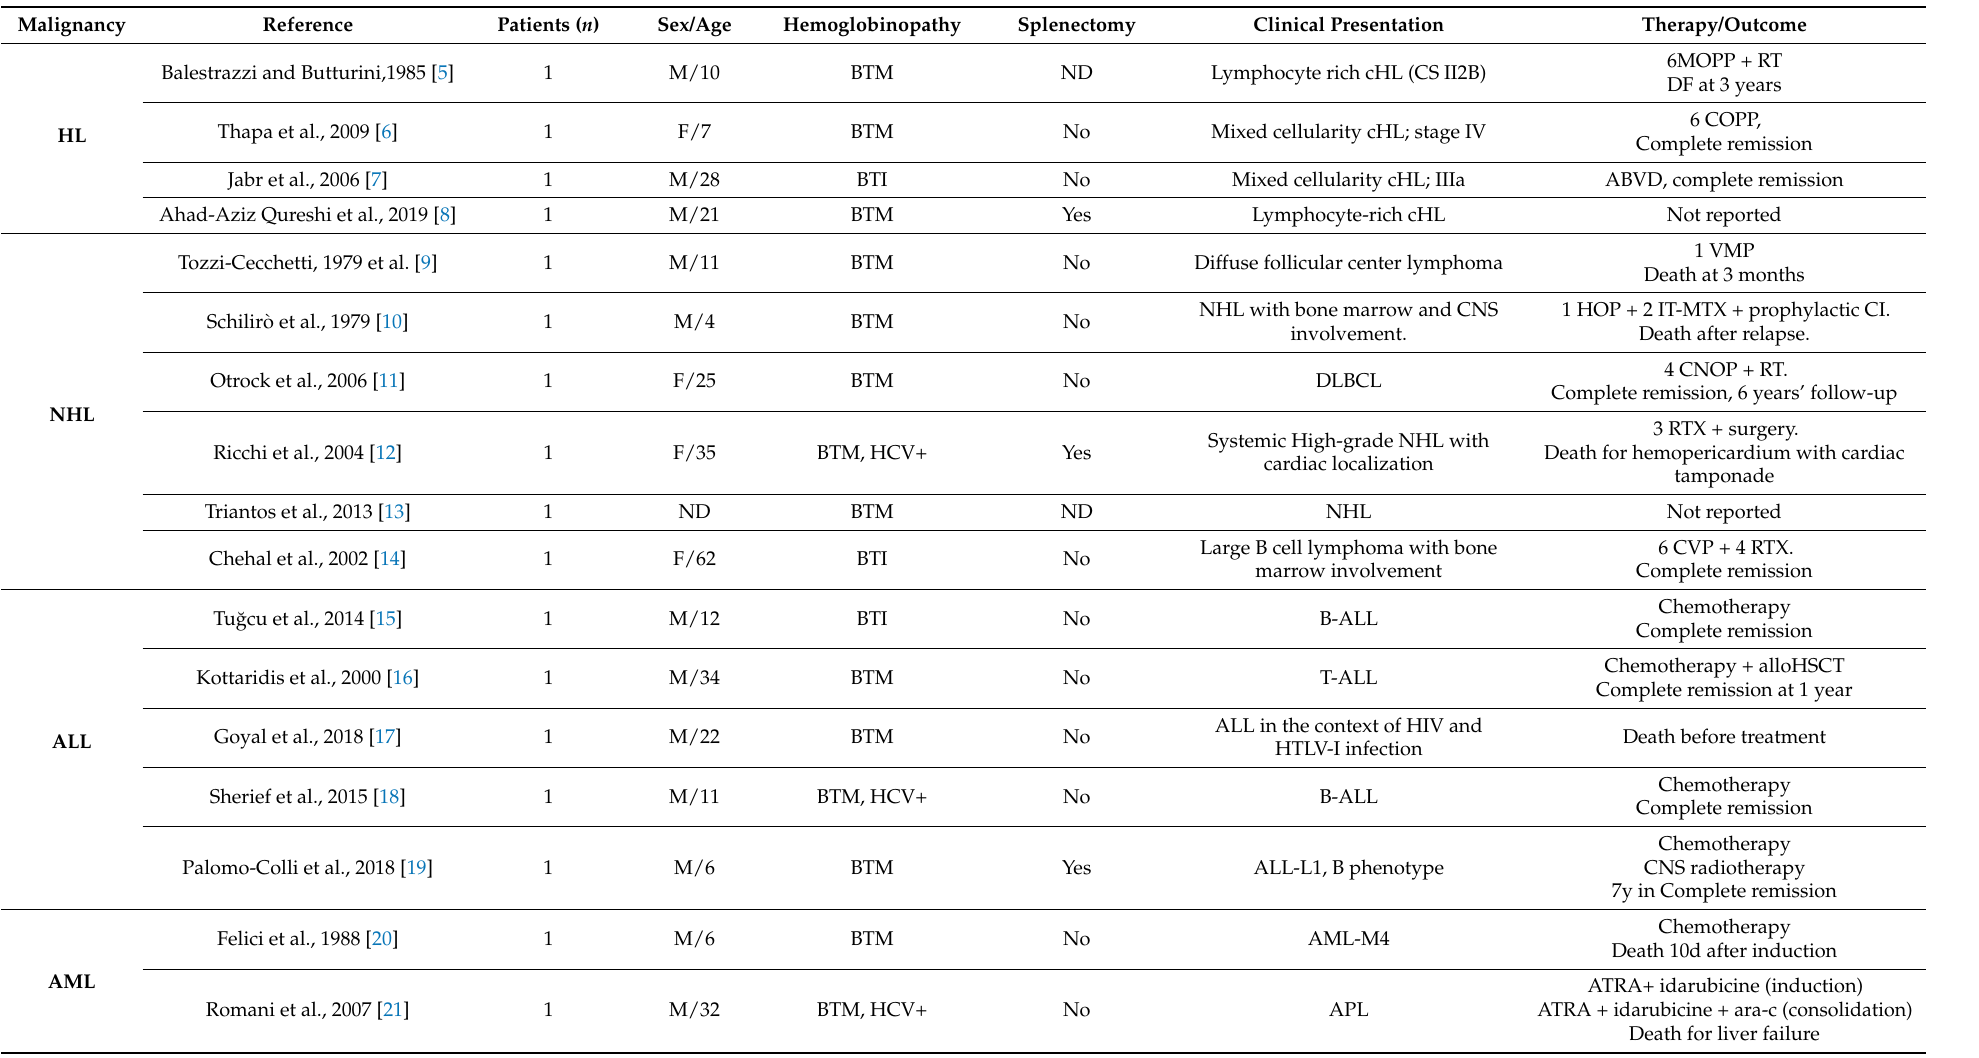
Table 1. Studies reporting the occurrence of hematological malignancies in transfusion dependent and independent β -thalassemia patients.